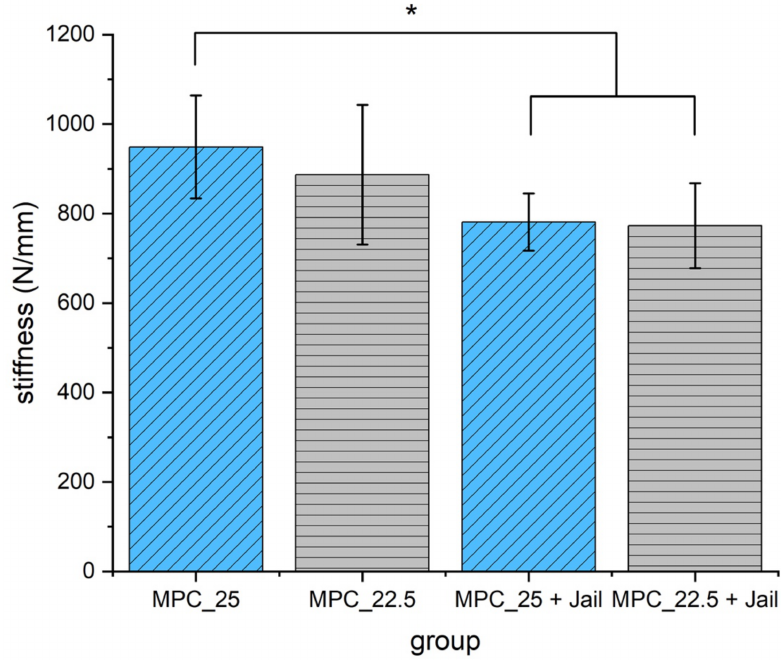
Figure 15. Stiffness of the reduced and fixed fractures with MPC and MPC plus screws in the jail technique. Stiffness of MPC_25 was significantly higher when compared to the two groups with additional screws ( p < 0.05, marked with an asterisk